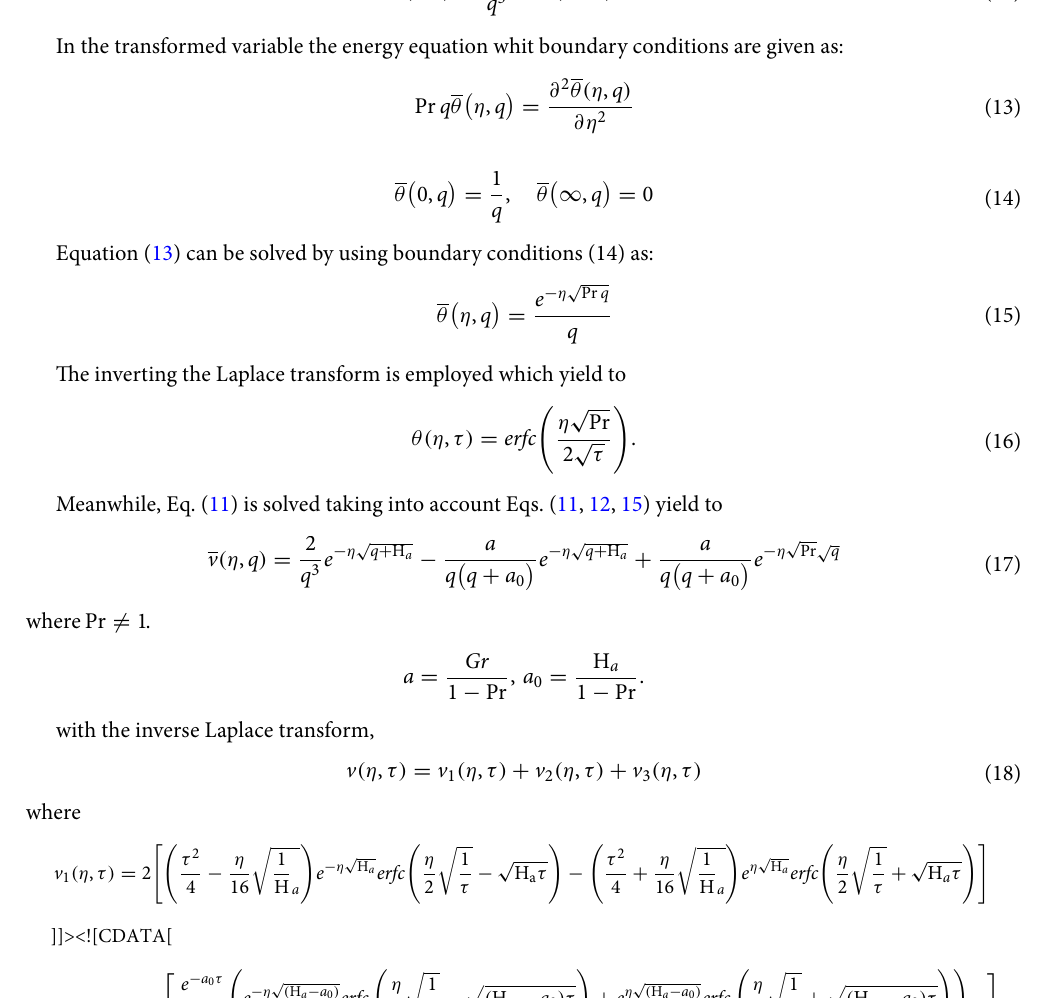
Skin friction. The skin friction of the system in dimensionless form is given by